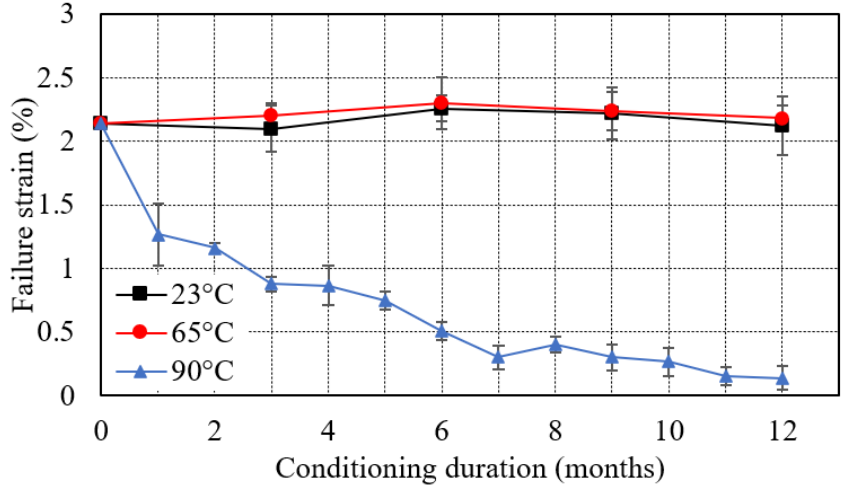
Figure 6. Effect of seawater immersion on failure strain (%).